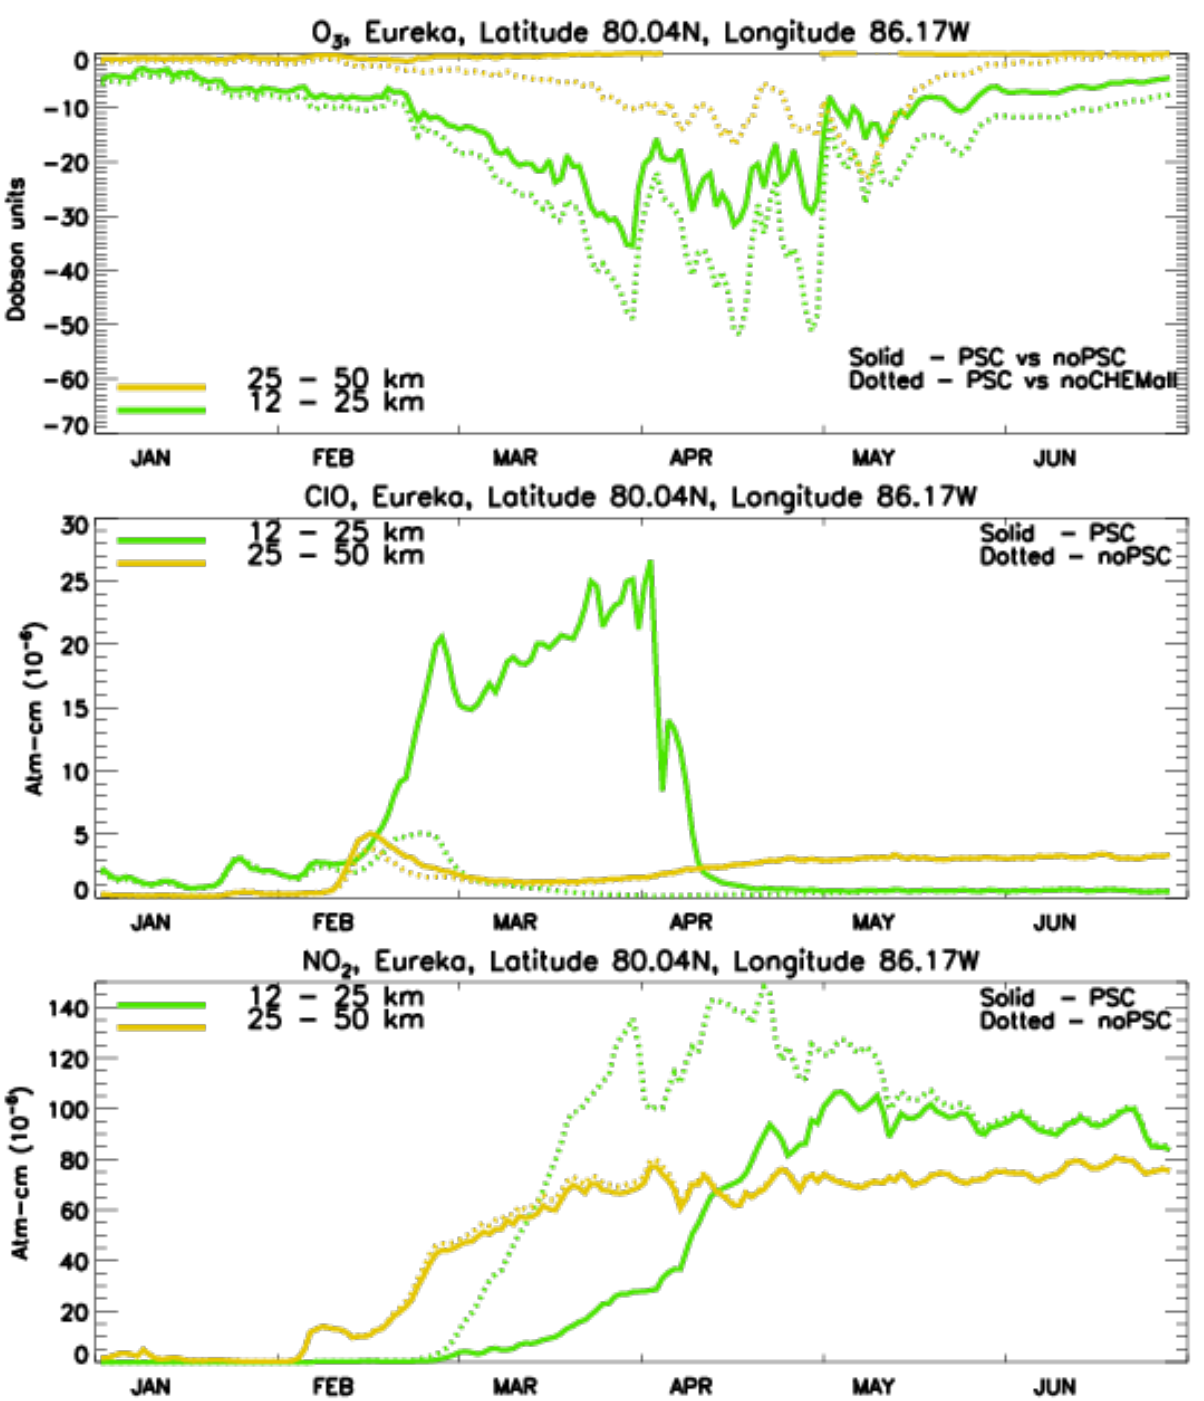
Figure 18. Eureka station values estimated with the CTM for the lower stratosphere (green) and the upper stratosphere (yellow): ( top ), the difference in ozone content for the scenarios PSC and noPSC (solid) and PSC, and PSC and noCHEM (dotted), chlorine monoxide ( middle ), and nitrogen dioxide ( bottom ) for the PSC (solid) and noPSC (dots).